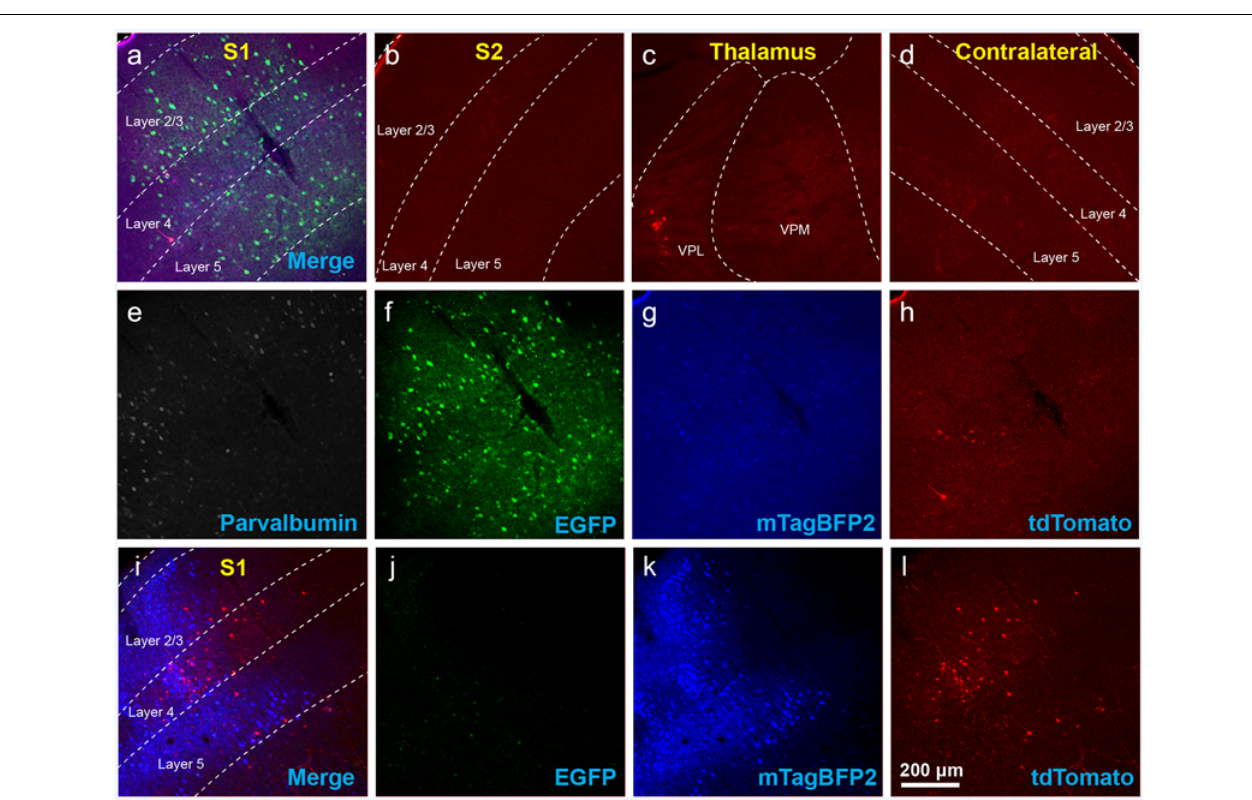
FIGURE 2 | Use of helper viruses at excessive concentrations can result in near-complete failure of monosynaptic tracing. The two-AAV combination described in Liu et al. (2017; AAV1-synP-FLEX-splitTVA-EGFP-B19G mixed with AAV1-TREtight-mTagBFP2-B19G) was injected in the somatosensory cortex of PV-Cre × Ai65F (FLPo-dependent tdTomato reporter) mice, followed by RV ∆ G-4FLPo(EnvA) 7 days later. (A–H) Very poor results were obtained when using new preparations of these AAVs undiluted. (A) Injection site in S1. Green = anti-EGFP staining, blue = mTagBFP2, red = tdTomato. Individual channels from this field are shown in panels (E–H) . (B) No labeled neurons were found in the ipsilateral secondary somatosensory cortex (S2). (C) Very few labeled neurons were found in ipsilateral thalamus (VPL and VPM). (D) No labeled neurons were found in contralateral S1. (E–H) Individual channels from the field shown in panel (A) . (E) Anti-parvalbumin staining (not shown in panel A ). (F) Anti-EGFP staining, indicating expression from the first, Cre-dependent AAV. (G) mTagBFP2, indicating expression from the second, tTA-dependent AAV. (H) tdTomato, reporting activity of the FLPo-encoding RV. (I , L) Injection site after using undiluted viruses in two-helper combination in Cre-negative animal: many labeled cells are seen. (I) Overlay of (J–L) . (J) Anti-EGFP staining, (K) mTagBFP2 signal, (L) tdTomato marking RV labeling. Scale bar in (A) : 200 µ m, applies to all panels.